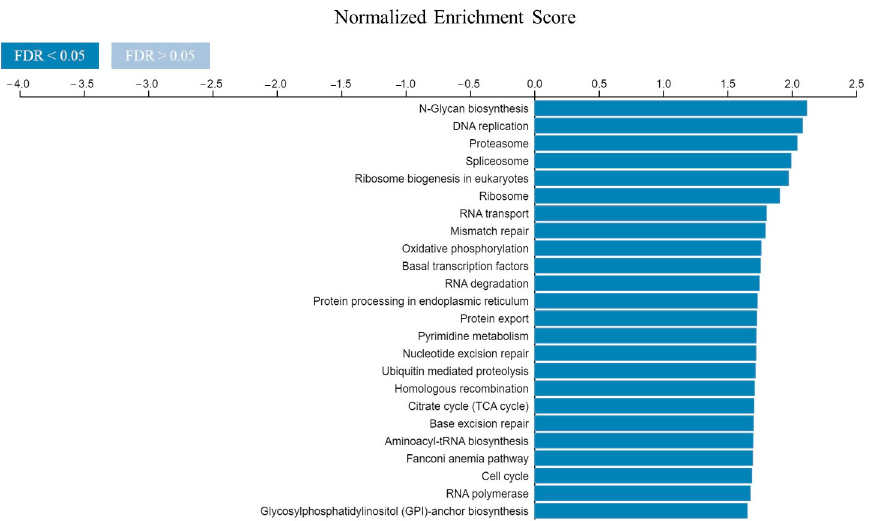
Figure 7. Gene set enrichment analysis (GSEA) of the KEGG pathways mostly enriched among genes positively related with both CDK4 and EXT2 , performed by LinkedOmics database. The colour of the bars indicates the values of false discovery rate (FDR).